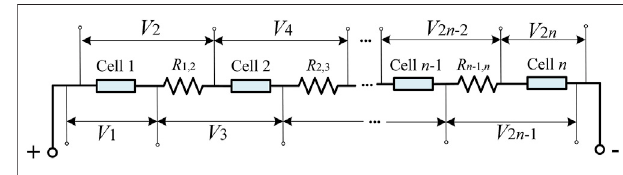
FIGURE 1 | Interleaved voltage measurement